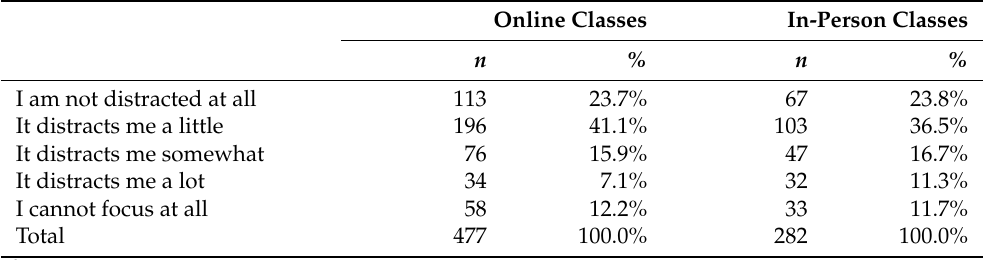
Table 5. How distracted are you when you use digital devices during class for reasons not related to school?